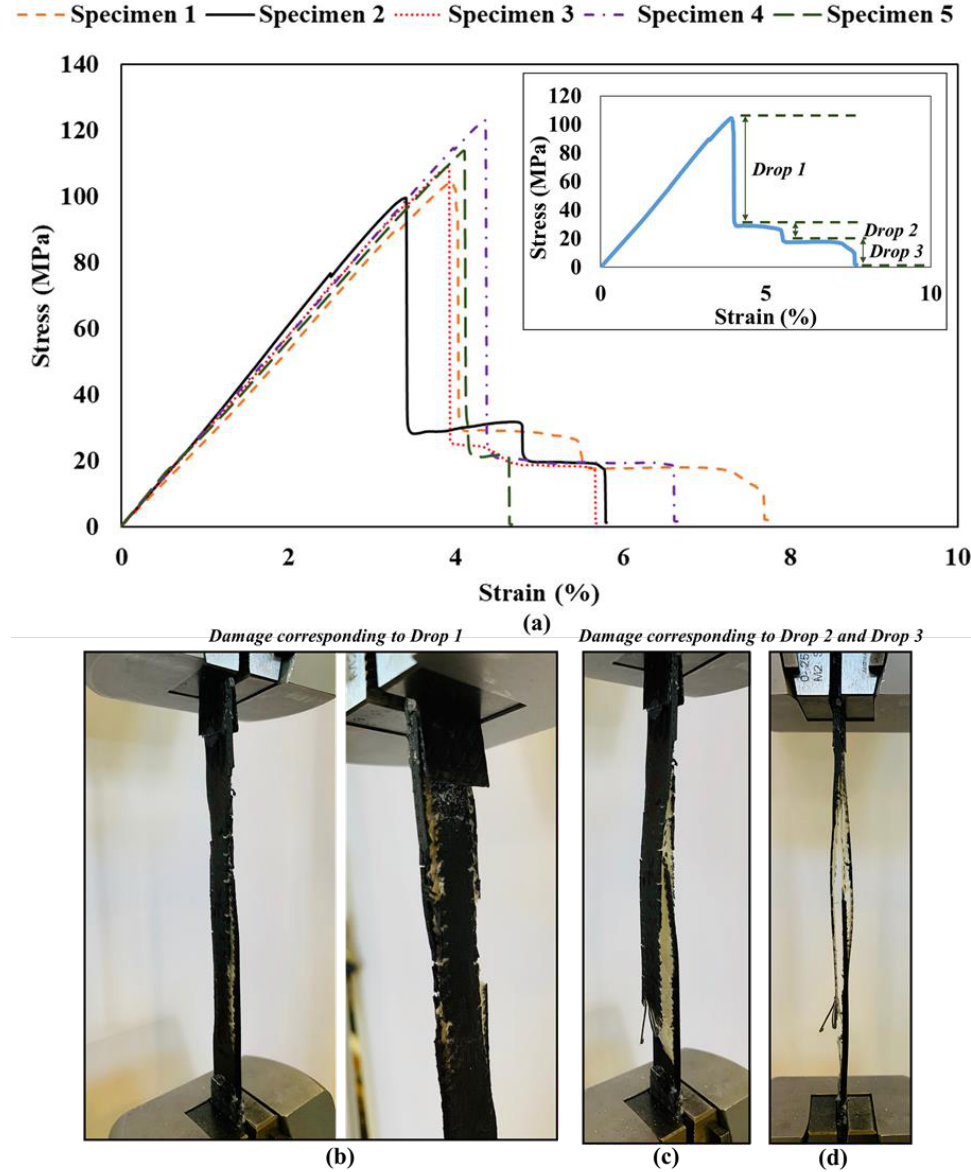
Figure 7. Multi-angled 3D-printed GFRP composite specimens (Set 2). ( a ) Tensile stress-strain behavior of all five specimens. ( b ) Damage corresponding to each stress Drop 1. ( c ) Damage corresponding to each stress Drop 2. ( d ) Damage corresponding to each stress Drop 3. Table 6. Material properties used in the finite element (FE) model.